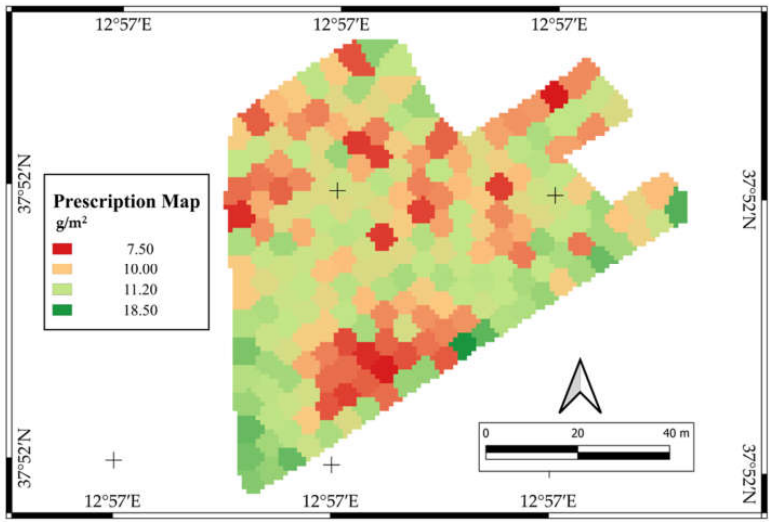
Figure 5. ( a ) Overlay between the production map (red-green scale) and the individual tree canopy with coloration according to NDVI value; and ( b ) particular of the image. The amount of N to be applied ranged from 7.5 to 18.5 g per square meter, corre- sponding on average to 255 g per plant. Figure 6 represents the prescription map of the amount of N to be applied. The plants were grouped into four different classes, according to the corresponding quartile.